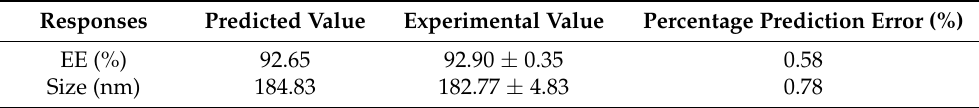
Table 4. Predicted and experimental values obtained from the response optimization of